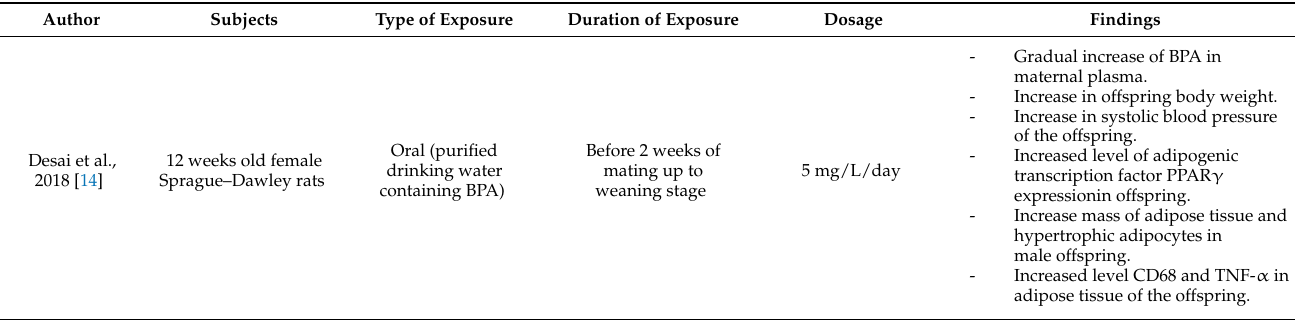
Table 1. BPA and obesity: in vivo